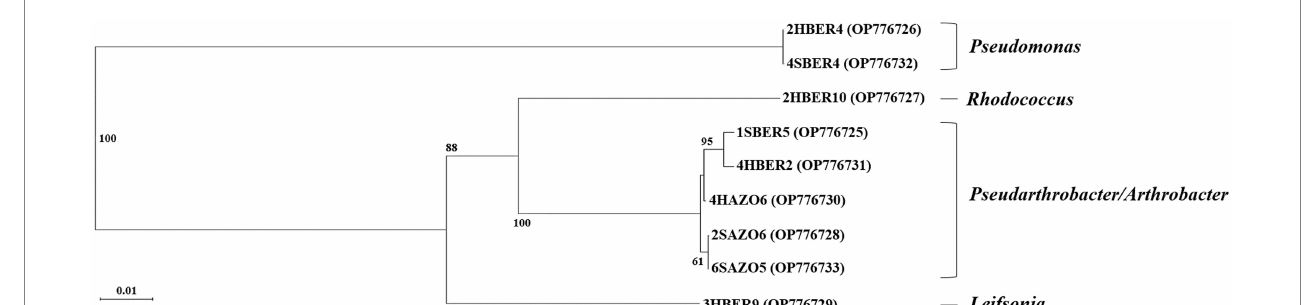
FIGURE 6 Phylogenetic tree based on sequences of the 16S genes (790 bp amplicon size) of 9 bacterial isolates obtained from A. prolifera and B. empetrifolia species from the north and south slopes of the Nevados de Chillán volcanic complex. 2HBER4, 2HBER10, 4HBER2, 3HBER9 correspond to isolates of the species B. empetrifolia on the south slope. 4SBER4, 1SBER5 correspond to isolates of the specie B. empetrifolia on the north slope. 4HAZO6 correspond to isolates of the specie A. prolifera on the south slope. 2SAZO6, and 6SAZO5 correspond to isolates of the species A. prolifera on north